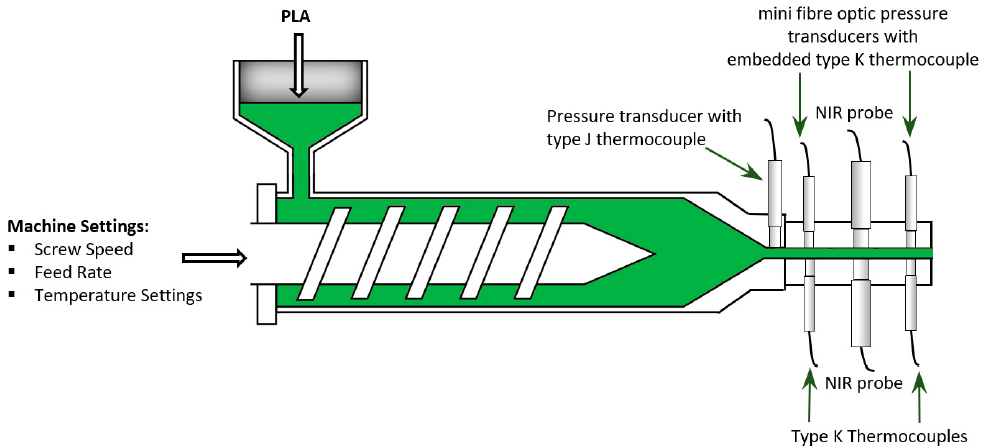
Figure 1. Schematic illustration of experimental